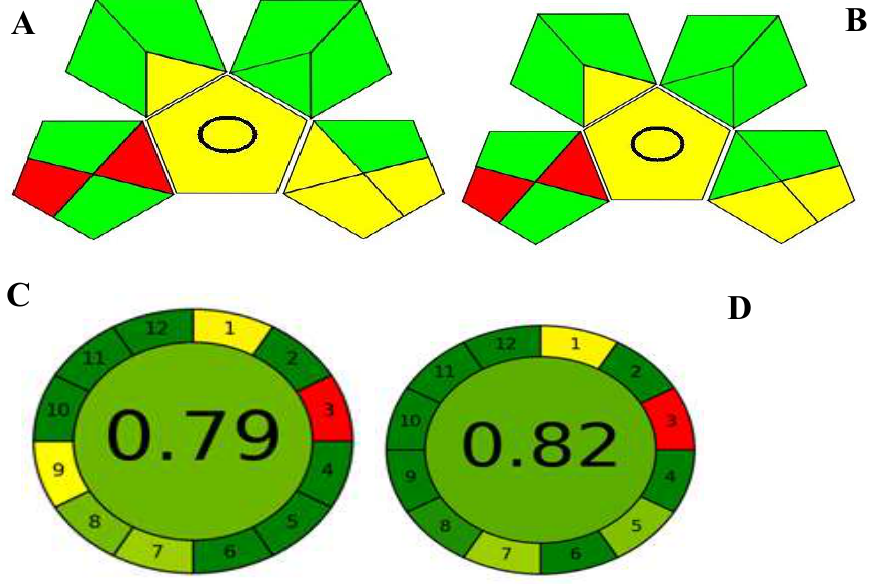
Figure 7. Evaluation of the greenness of the proposed HPLC ( A ) and chemometric ( B ) methods using the GAPI metric, the AGREE metric ( C ) HPLC, and ( D ) chemometric methods. AGREE uses clock-shaped graphical representation, where the perimeter is divided into 12 zones, each representing one of the GAC principles. The color code is nearly similar to the GAPI ranging from red to yellow and green to indicate ecological impact; however, its colors can range from lighter to darker intensities. AGREE has the advantage over GAPI in providing a numerical estimation of greenness score positioned in the center of its graph [37]. Figure 7C,D represent the AGREE assessment of the studied methods where the spectroscopic method exceeds the HPLC method in the overall calculated score. Both the GAPI and AGREE results were found to be